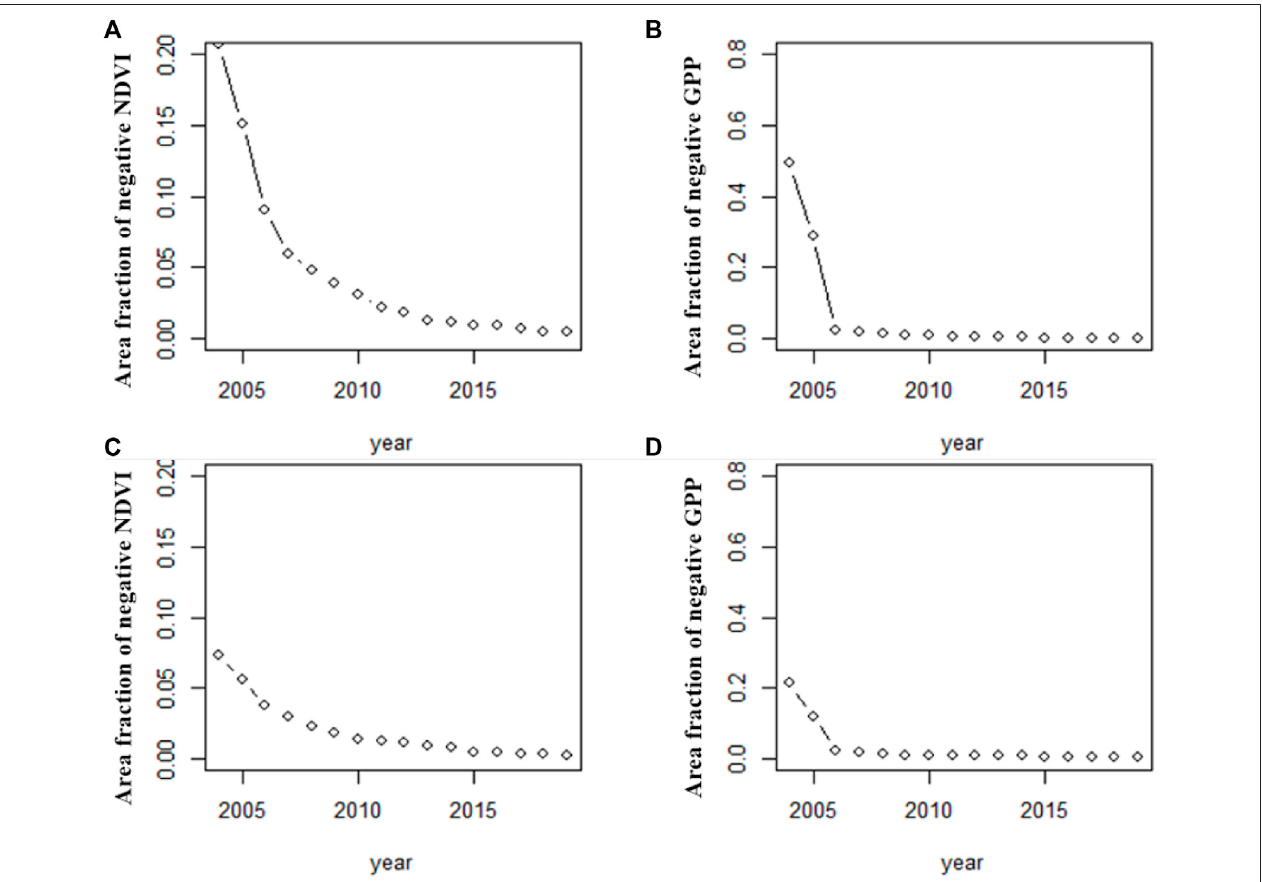
FIGURE 7 | Area fraction of negative NDVI (A,C) and GPP (B,D) throughout DC and AC in the karst (A,B) and non-karst areas (C,D) in the study area.